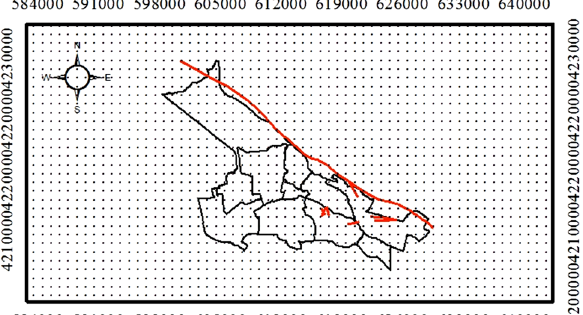
Fig. 4 The points of artificially produced